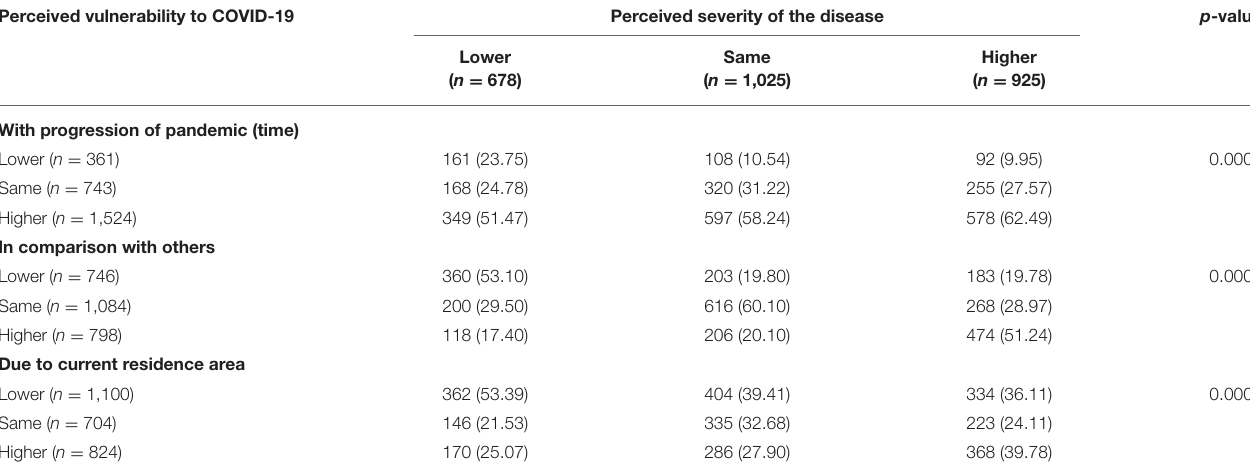
TABLE 4 | Threat appraisal related to COVID-19.